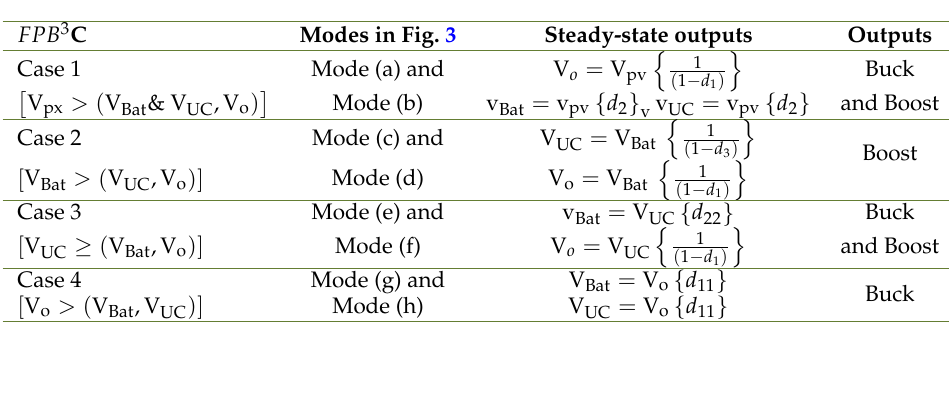
Table 2. STEADY STATE RESULTS OF FPB 3 C